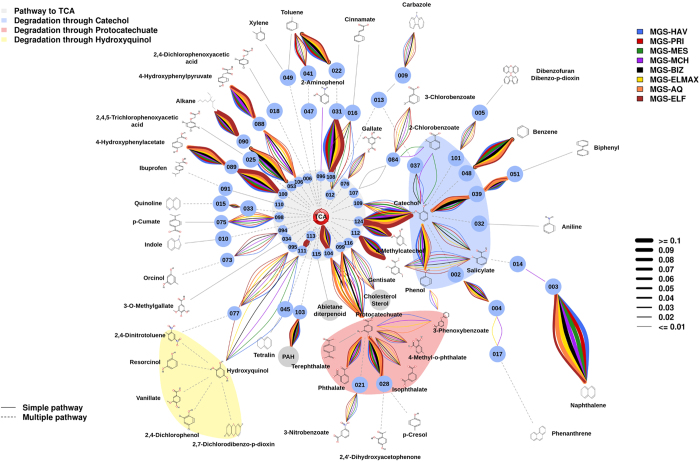
Potential aerobic and/or anaerobic degradation networks of alkanes and aromatics via di- and trihydroxylated intermediates in the investigated communities (see color code) after combining DNA- (Supplementary Fig. S2) and 16S rRNA-based (Supplementary Fig. S3) analyses.The biodegradation network reconstruction was performed as described in Supplementary Methods. Briefly, predicted open reading frames (ORFs) in the DNA or 16S rRNA-derived meta-sequences were filtered by score (>45) and e-value (<10e−3) according to their similarity to the sequences of key aromatic catabolic gene families involved in the degradation of aromatic pollutants and alkanes2427. After a manual check, a final list of gene sequences encoding enzymes potentially involved in degradation was prepared. For network reconstruction, each sequence was assigned to a metabolic substrate and a product with an assigned code, and the putative substrates and products processed in the sample were connected, creating a metabolic network using appropriate scripts and commands (for details, see Supplementary Methods). The rel. ab. of each catabolic gene assigned to degradation reactions, as represented by the thickness of the lines in the figure, and the complete list of substrates possibly degraded by the communities are summarized in Supplementary Table S5. Confidence greater than 90% as indicated in Supplementary Table S5. Note that rel. ab. refers to the total number of genes in a given sample to avoid artifacts due to differences in sample size. The codes for the chemical species in each pathway are as described in Supplementary Fig. S2 and Table S5A.